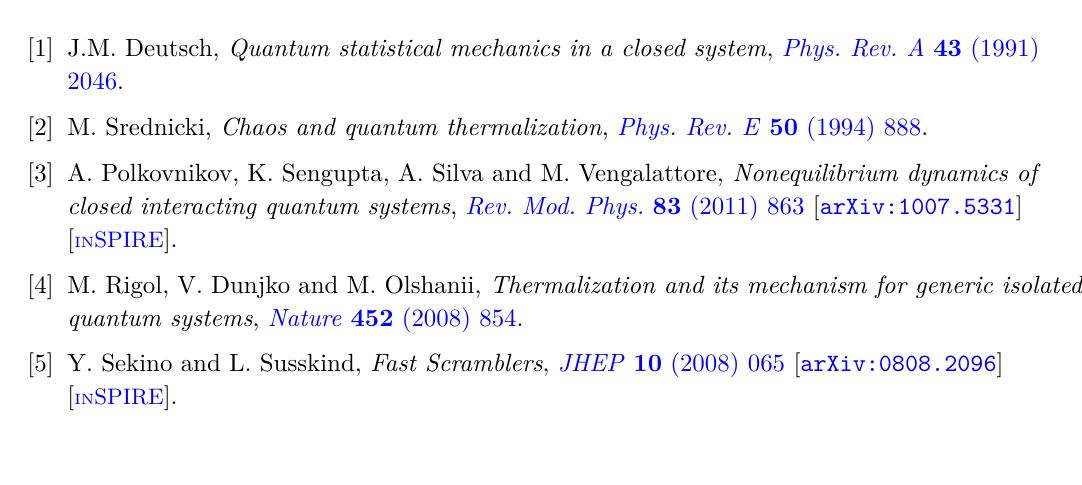
Figure 14 . (a) The log-behavior of different sectors within the (1 , N − 2 , 1) contribution to the ) OTOC for N = 500 , compared with straight line fits with slope − λ ρ F m ( χ i ( t ) , χ † j ln( ρ (1 − ρ ) ) for the corresponding ρ . (b) The log-behavior of different sectors within the (0 , N − 2 , 0) contribution to the F m ( n ( t ) , n ) OTOC for N = 500 , compared with straight line fits with slope i j and intercept ln( ρ (1 − ρ ) ) for the corresponding ρ . The irreps in both (a) and (b) exponentially − λ ρ L decay in each charge sector and therefore do not contribute to the scrambling